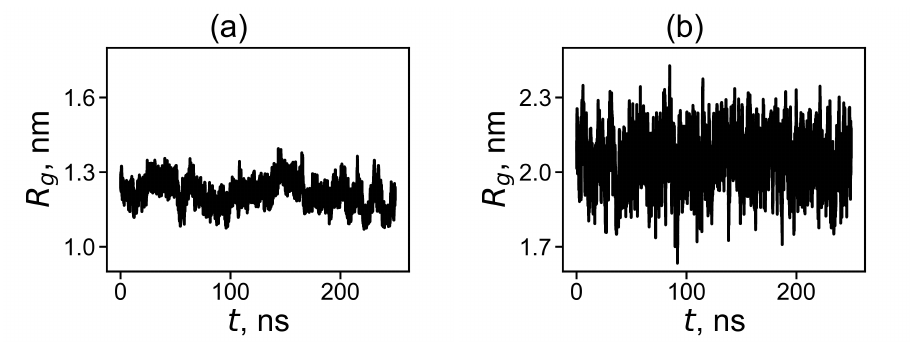
Figure 2. The time evolution of the instant radius of gyration R g at 310 K for ( a ) Lys-2His and ( b ) Lys-2Hisp.